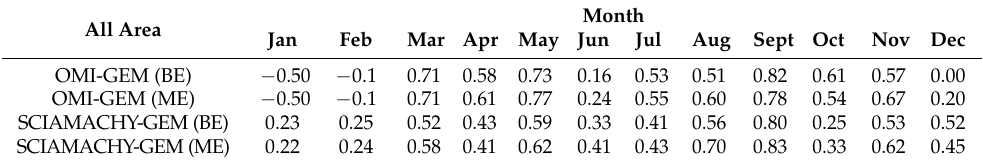
Table 8. Correlation coefficients between NO 2 tropospheric column from satellite data and GEM-AQ base emission (BE) and modified emission (ME) for 2011 for the Silesia part of the modelling